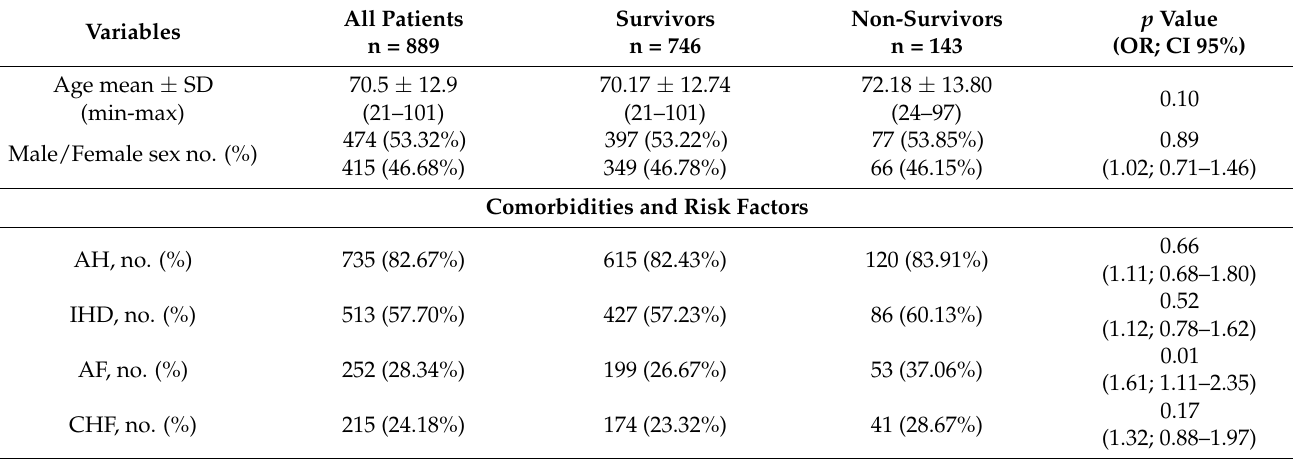
Table 2. The baseline characteristics data of all patients divided according to